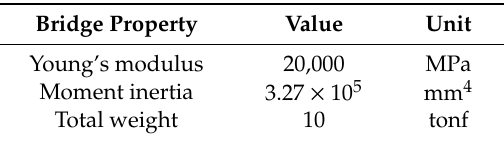
Table 9. Bridge properties.